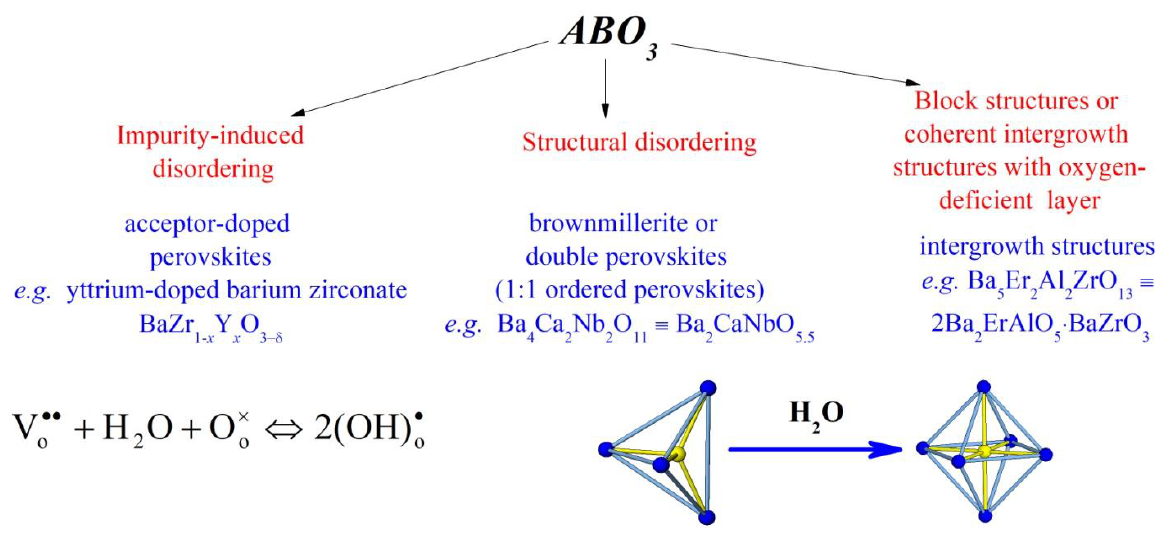
Figure 1. Main methods for modifying of perovskite structure to create an oxygen deficiency, the examples of basic materials and basic concepts of water incorporation.